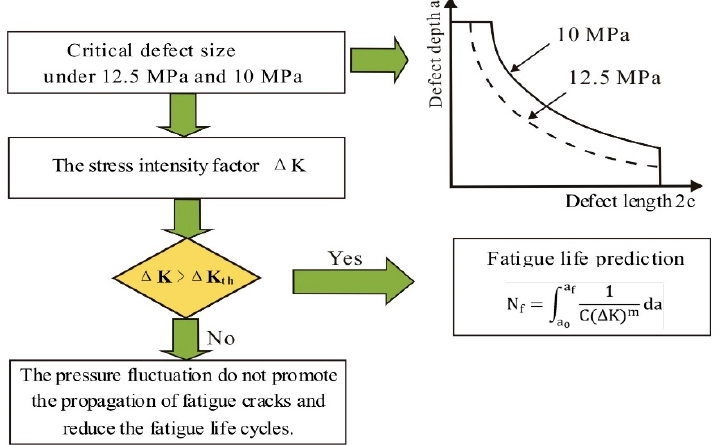
Figure 15. System flow of fitness-for-service assessment for pipelines with potential leakage risk.